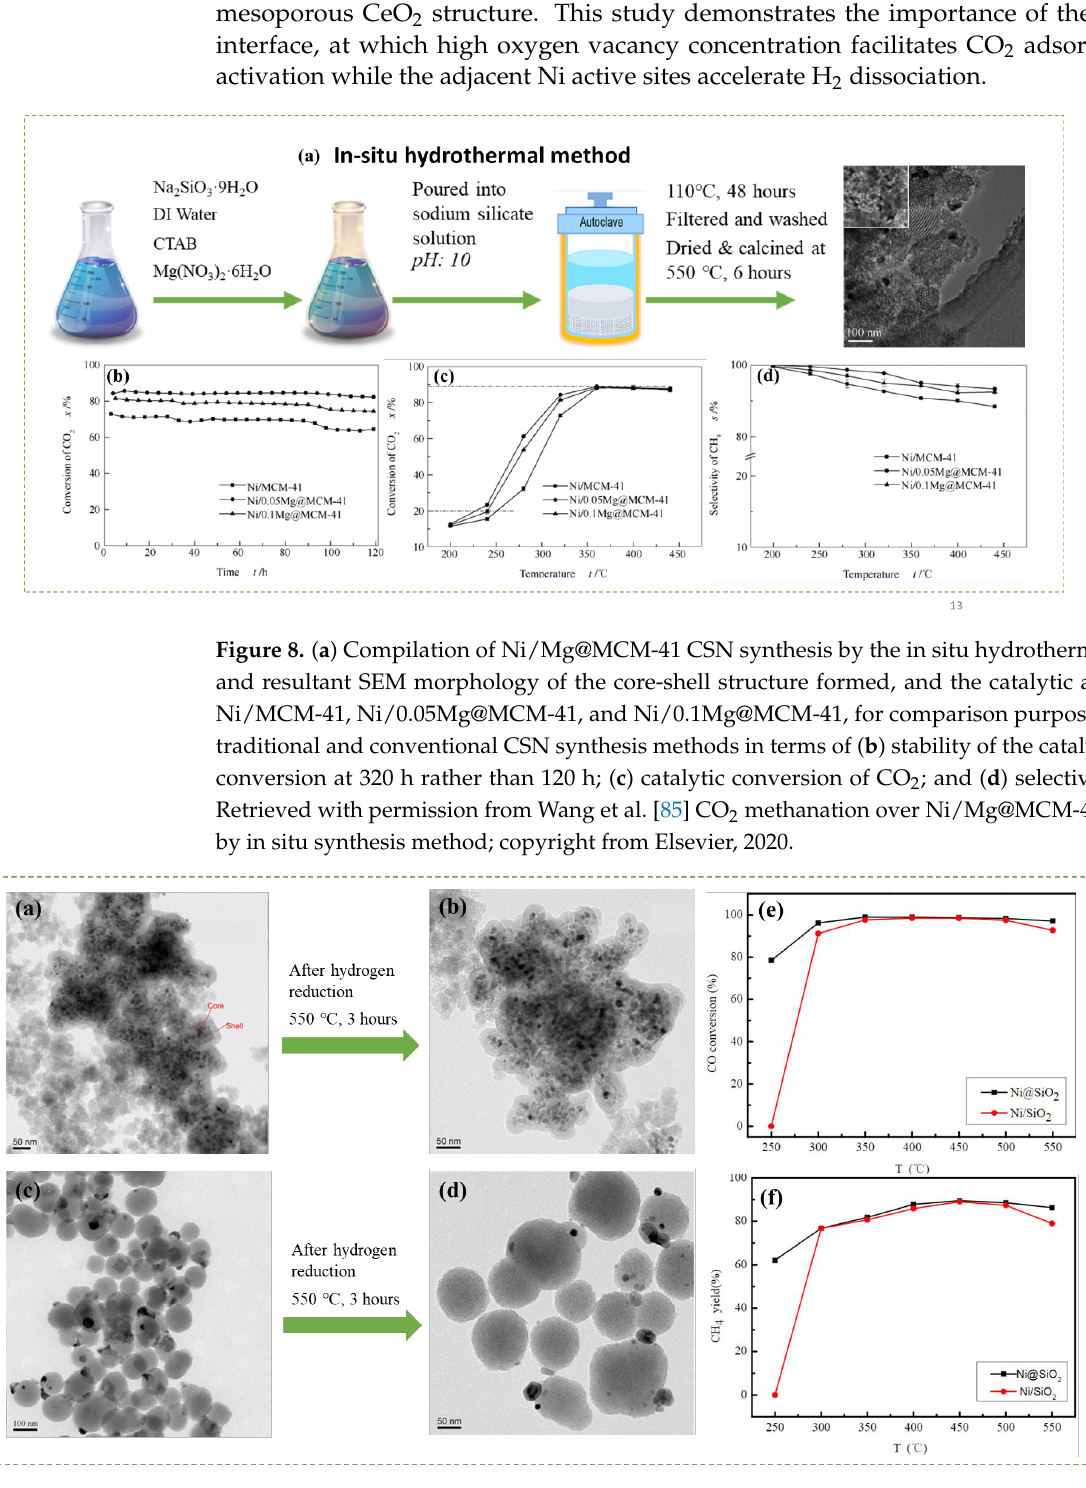
Figure 9. HR-TEM image of ( a , c ) fresh Ni@SiO 2 and Ni/SiO 2 ; ( b , d ) Ni@SiO 2 and Ni/SiO 2 after hydrogen treatment at 550 °C; ( e , f ) catalytic performance of Ni@SiO 2 and Ni/SiO 2 catalysts in CO methanation. Retrieved from Han et al. [86] Core-Shell Structured Ni@SiO 2 Catalysts Exhibiting Excellent Catalytic Performance for Syngas Methanation Reactions; copyright from MDPI, Catalysts , 2017.